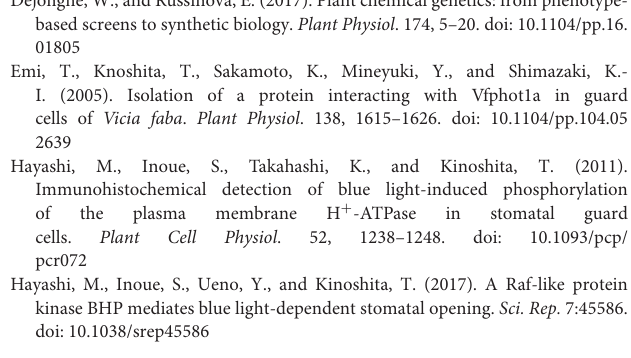
Table 3 . In soybean, glycine max1-matrix metalloproteinase (GM1-MMP) and glycine max2-matrix metalloproteinase (GM2- MMP) are PM proteins, and the stomatal aperture of transgenic Arabidopsis plants overexpressing GM1 - MMP and GM2 - MMP was significantly larger than the WT (Liu et al., 2017, 2018), suggesting that GM1 - MMP and GM2 - MMP regulate stomatal opening. Therefore, AtMMPs are candidate targets of PI3 in